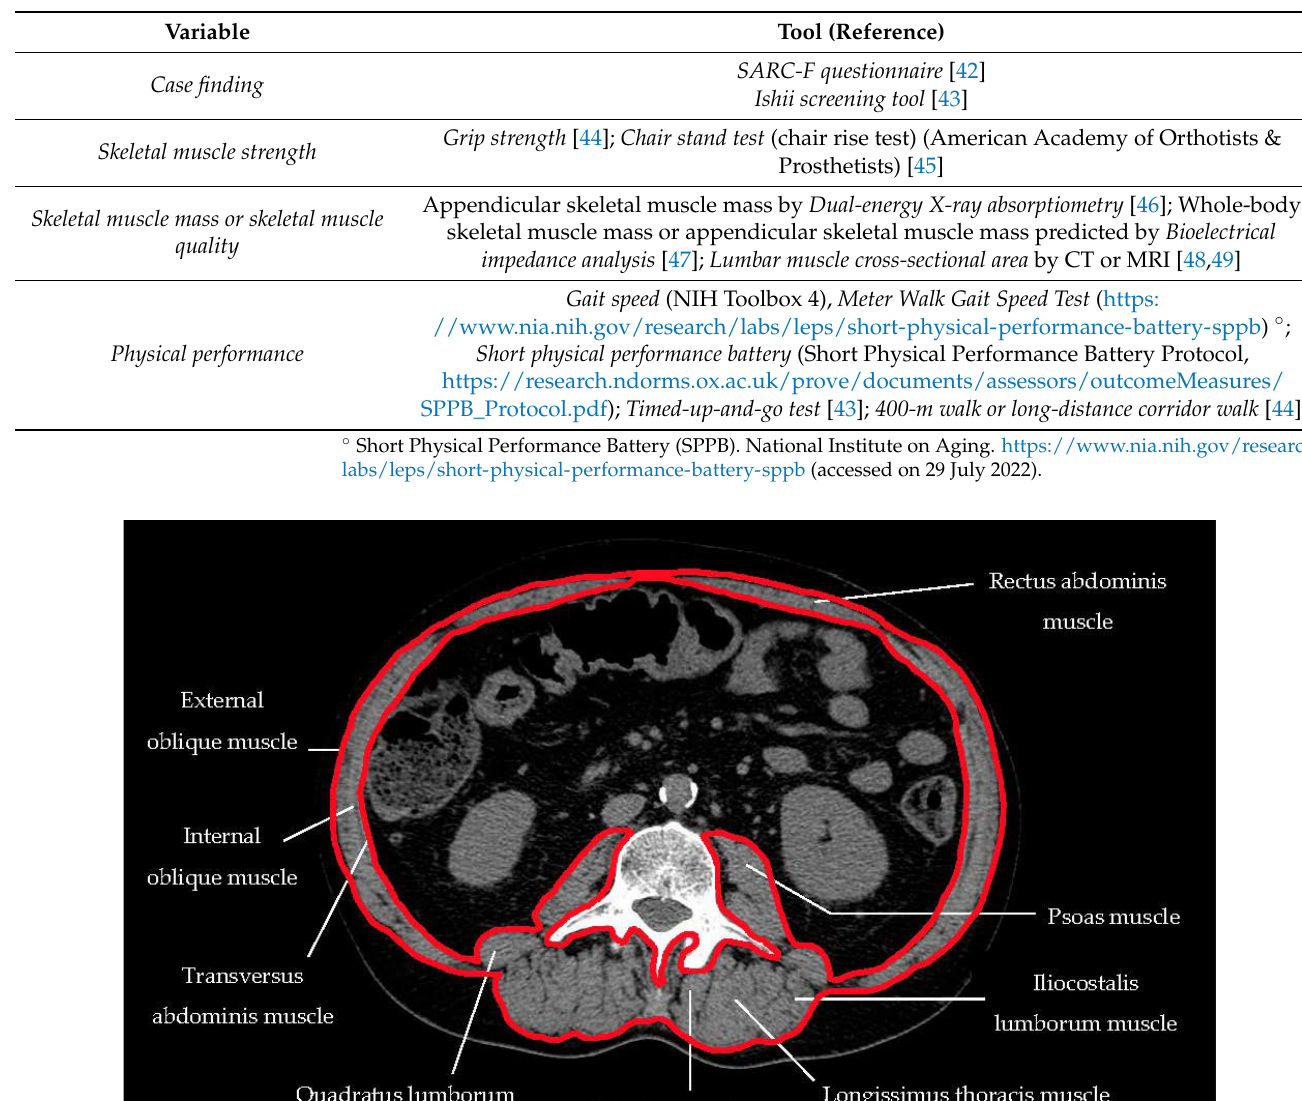
Table 1. Tools to screen sarcopenia in clinical practice (From Cruz-Jentoft AJ et al., adapted [41]).